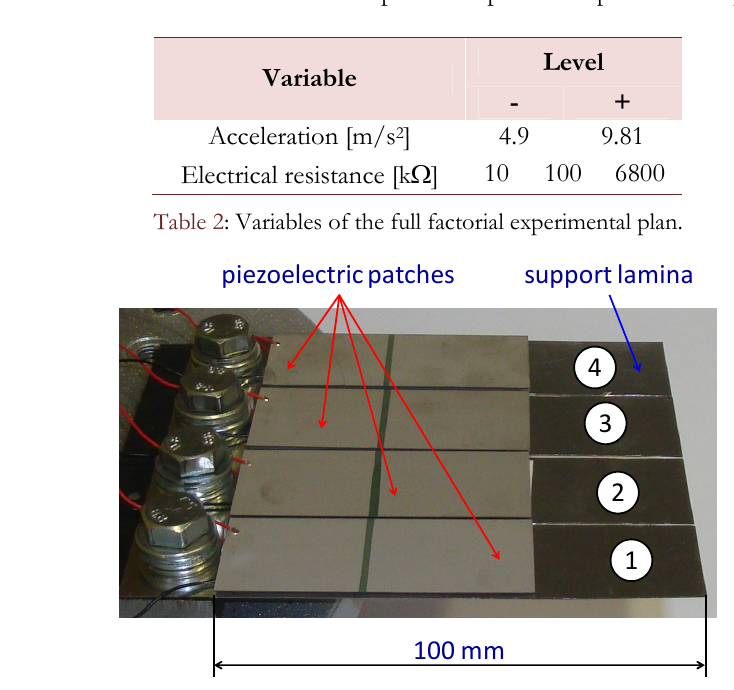
Figure 3: Physical prototype of the fractal-inspired piezoelectric converter.